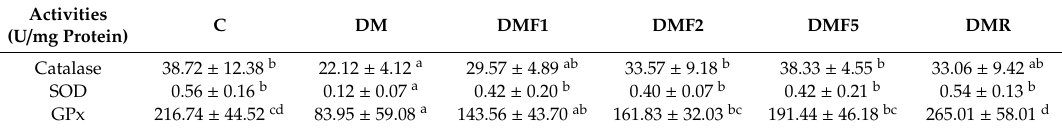
Table 2. E ff ects of fucoxanthin on enzymatic antioxidant activities of rat plasma after treatment for four weeks.